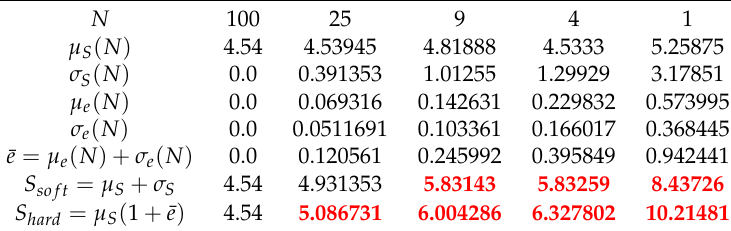
Table 3. Results for the flatworm average trap counts obtained on a sequence of coarse grids from the data in Figure 4a. The mean value µ S ( N ) and the standard deviation σ S ( N ) are computed for the average trap count S c on a sequence of quasi-regular grids with number N of sampling locations. For any realisation of the average trap count the error (2) is computed. Given K realisations of error (2), the mean evaluation error µ e ( N ) , the standard deviation σ e ( N ) of the evaluation error, and the upper error bound µ e ( N ) + σ e ( N ) are computed for each N in the table. The values of the estimate of the average trap count that exceed the hypothetical management point of S T = 5 flatworms per trap are shown in